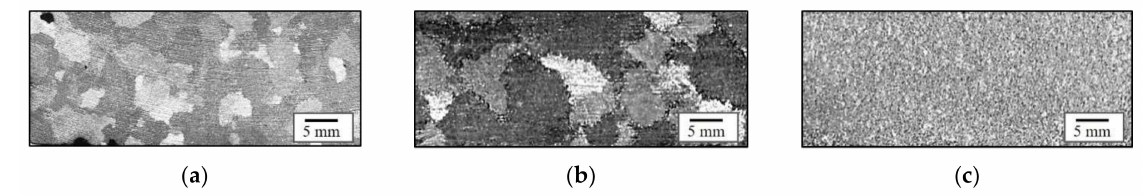
Figure 2. Macrostructure of eutectic alloy 4 depending on treatment: ( a ) untreated; ( b ) standard flux; ( c ) complex flux.